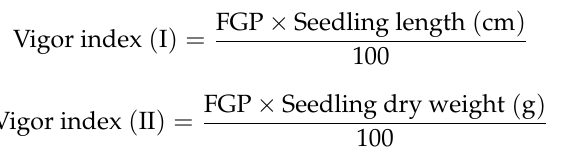
Figure 4. Optical emission spectrum of gliding arc discharge in the ambient air.